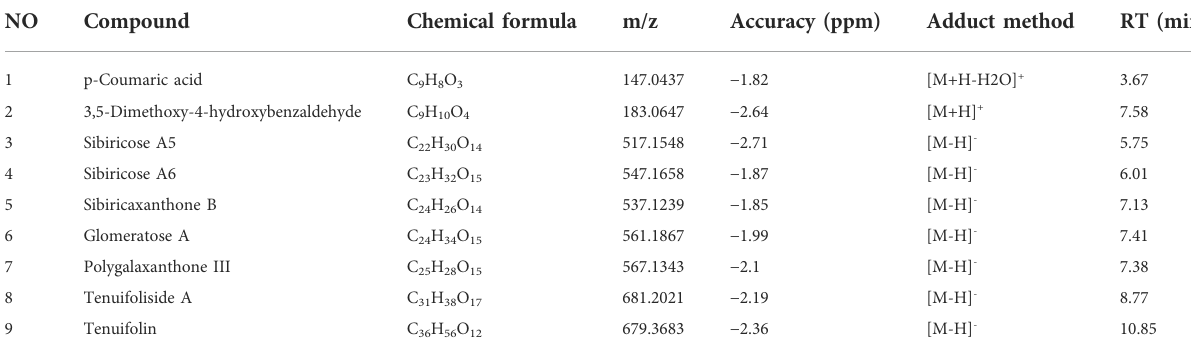
TABLE 4 UPLC-MS characterization of the main components of